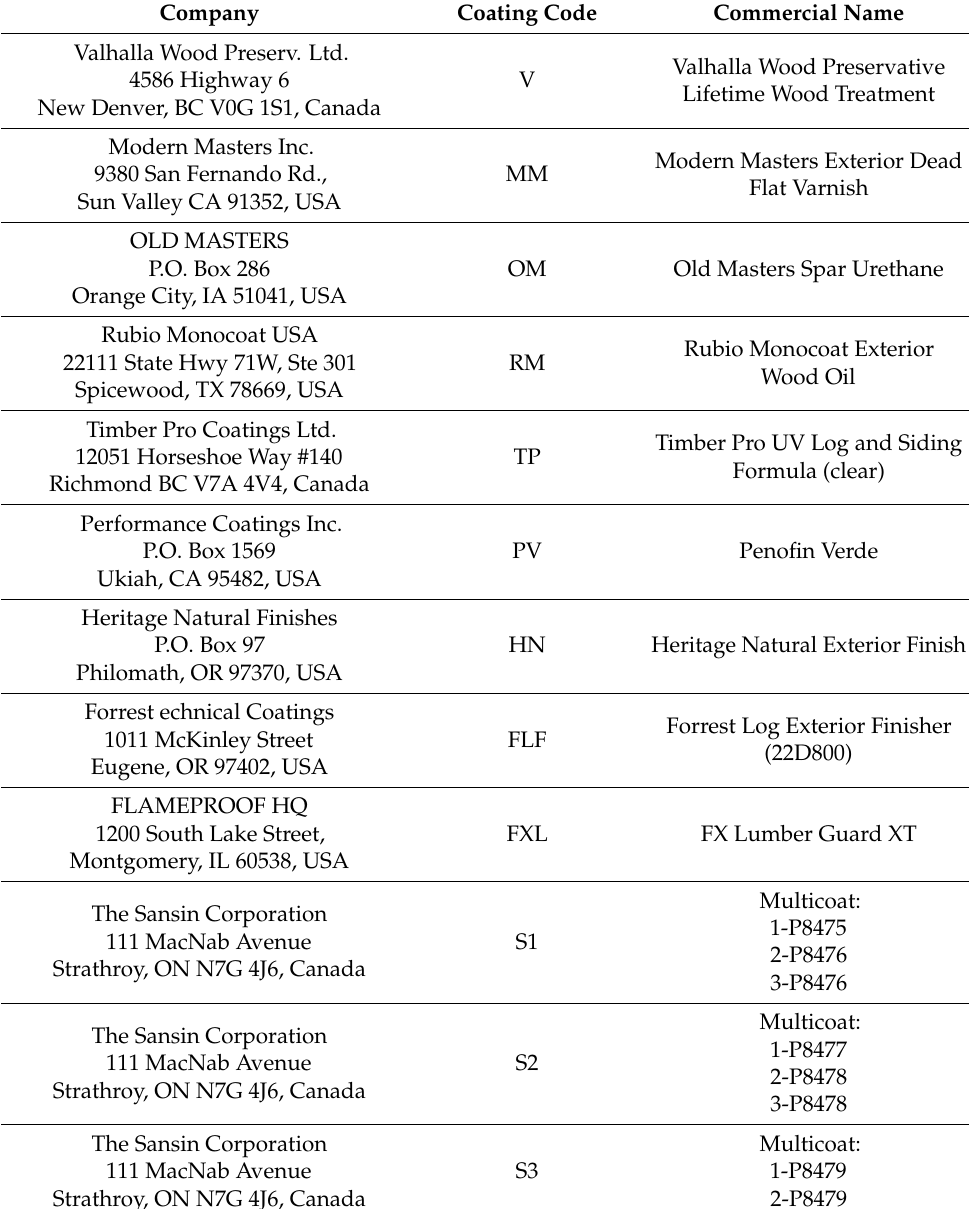
Table 1. Coatings that were evaluated for their ability to protect four untreated wood species and acetylated radiata pine in an above-ground field